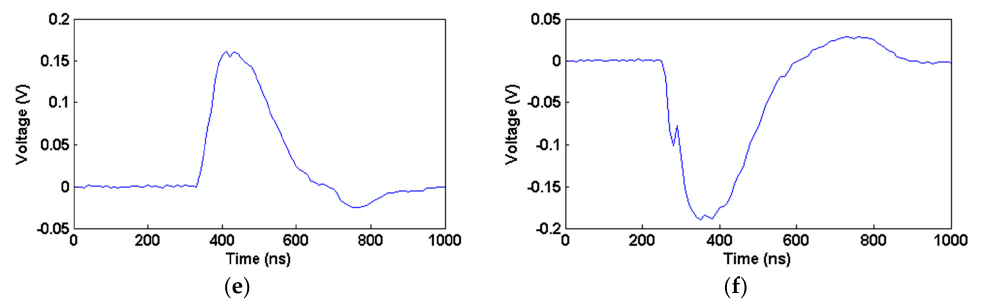
Figure 13. Single PD pulses of three models. ( a ) Positive half cycle of needle-plate; ( b ) Negative half cycle of needle-plate; ( c ) Positive half cycle of surface discharge; ( d ) Negative half cycle of surface discharge; ( e ) Positive half cycle of air gap; ( f ) Negative half cycle of air gap.